Question: Summarize what this figure shows in one sentence.
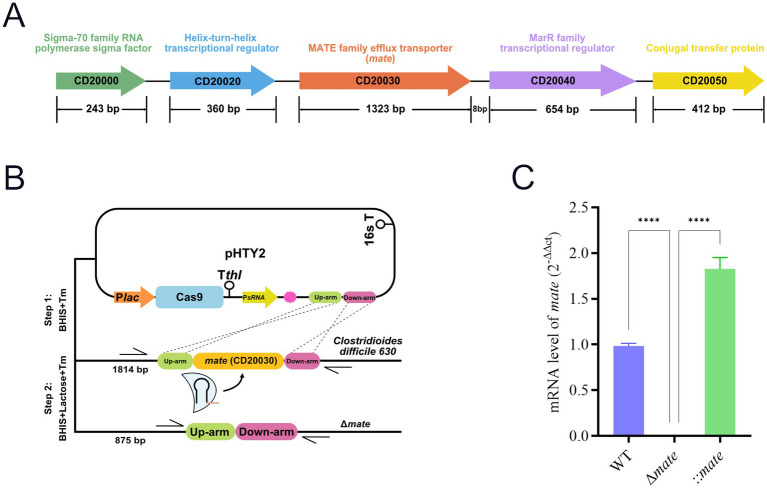
Answer: Gene context of the mate gene and CRISPR-Cas9 mediated gene deletion of the mate . (A) Gene context of the mate gene, which is flanked by CD20020 and CD20040 genes. (B) A two-step selection process was employed to isolate the ∆ mate mutant in C. difficile . Step 1, Plasmid pHTY2 was conjugated into C. difficile under the selection of Tm; Step 2, lactose was added to the BHIS medium to induce the expression of the Cas9. (C) RT-qPCR showed that in the expression of the mate gene no longer detectable in the ∆ mate mutant, whereas it was restored in the :: mate complementary strain. Data were presented as mean ± SEM. Statistical significance was determined using one - way ANOVA, followed by Tukey’s post hoc test. **** P < 0.0001.